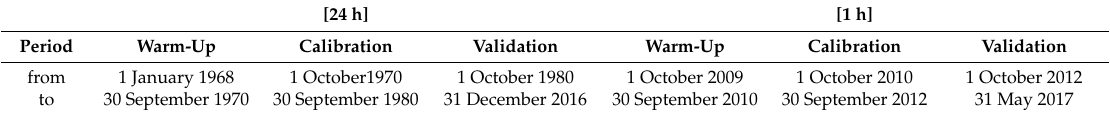
Table 1. Warm-up, calibration and validation periods for KarstMod